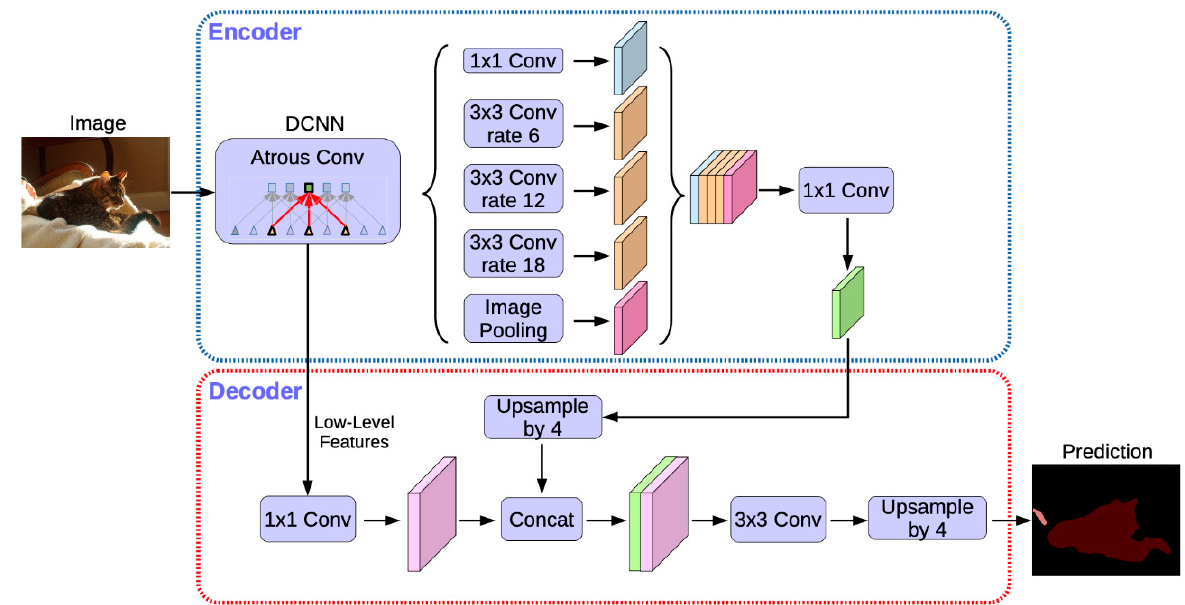
Figure 3. DeepLabv3+ architecture